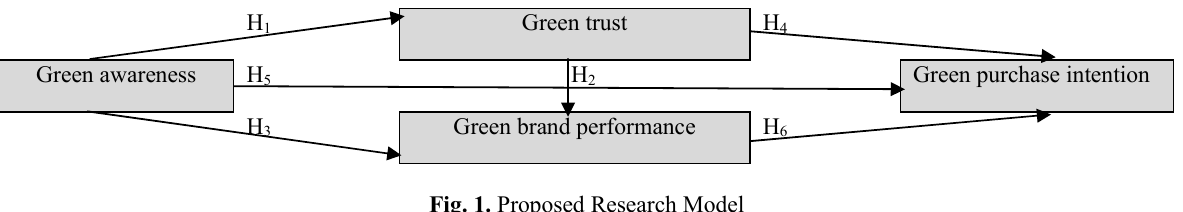
Fig. 1. Proposed Research